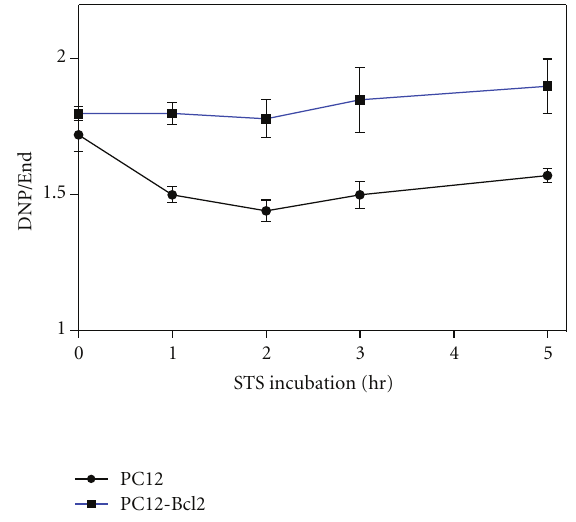
Figure 5: Uncoupling ratio behaviour in STS treated PC12 and PC12-Bcl-2 cells. Ratio between absolute DNP-uncoupled oxygen consumption and endogenous respiration expressed in nanomoles of oxygen consumed per minute and per mg of cellular proteins (nmolO 2 /min/mg) of PC12 and PC12-Bcl-2 cells under 2 μ M STS-treatment for the indicated time. In detail, for the indicated time points (0h, 1 h, 2 h, 3h, 5h), endogenous respiration oxygen consumption values are 14,82; 13,99; 12,75; 10,12; 11,10 nmolO 2 /min/mg for PC12 cells and 15,82; 12,78; 10,94; 10,98; 9,81 nmolO 2 /min/mg for PC12-Bcl-2 cells. DNP- uncoupled oxygen consumption values are 25,50; 20,99; 18,36; 15,17; 17,43 nmolO 2 /min/mg and 28,48; 23,14; 19,48; 20,31; 18,64 nmolO 2